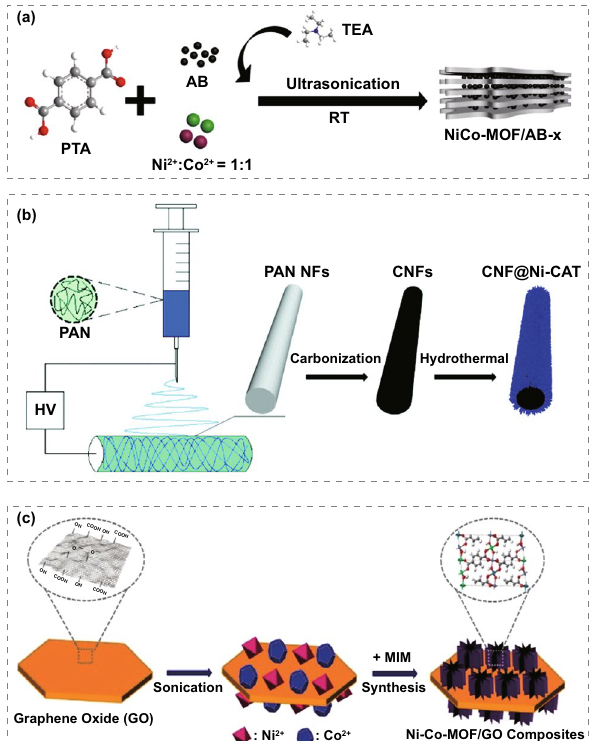
Fig. 7 a Schematic diagram of the synthesis of NiCo-MOF/AB com- posites. Reprinted with permission from Ref. [112]. Copyright 2019 Elsevier B.V. b Synthesis diagram of CNF@Ni-CAT. Reprinted with permission from Ref. [113]. Copyright 2019 Royal Society of Chem- istry. c Preparation process diagram of Ni-Co-MOF/graphene oxide composites. Reprinted with permission from Ref. [114]. Copyright 2019 Elsevier